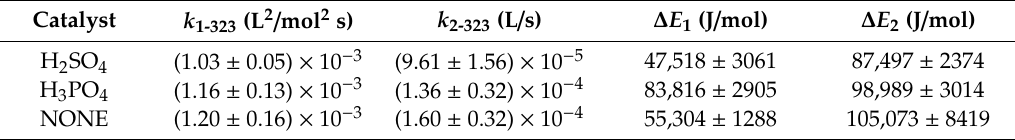
Table 2. Kinetic parameters for the formation and decomposition of performic acid in di ff erent environment taken from [13]. Here, 323 K has been taken as the reference